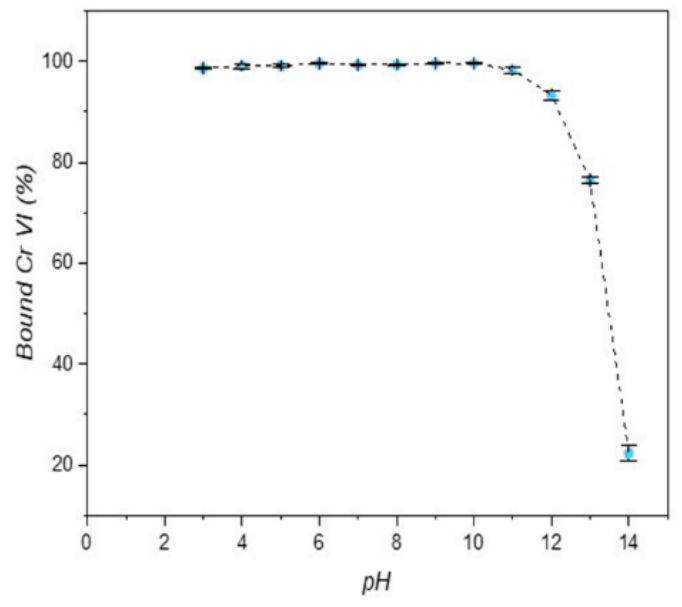
Figure 6. Trend in Cr(VI) adsorption capability vs. pH.